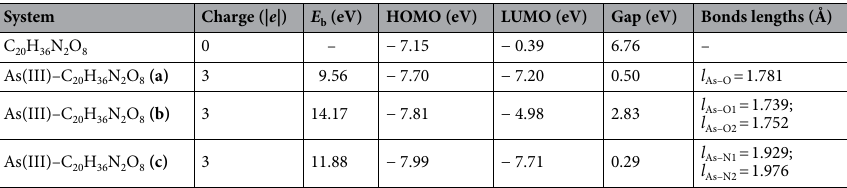
Table 1. Calculated characteristics of the C 20 H 36 N 2 O 8 molecule and its complexes with the As(III)